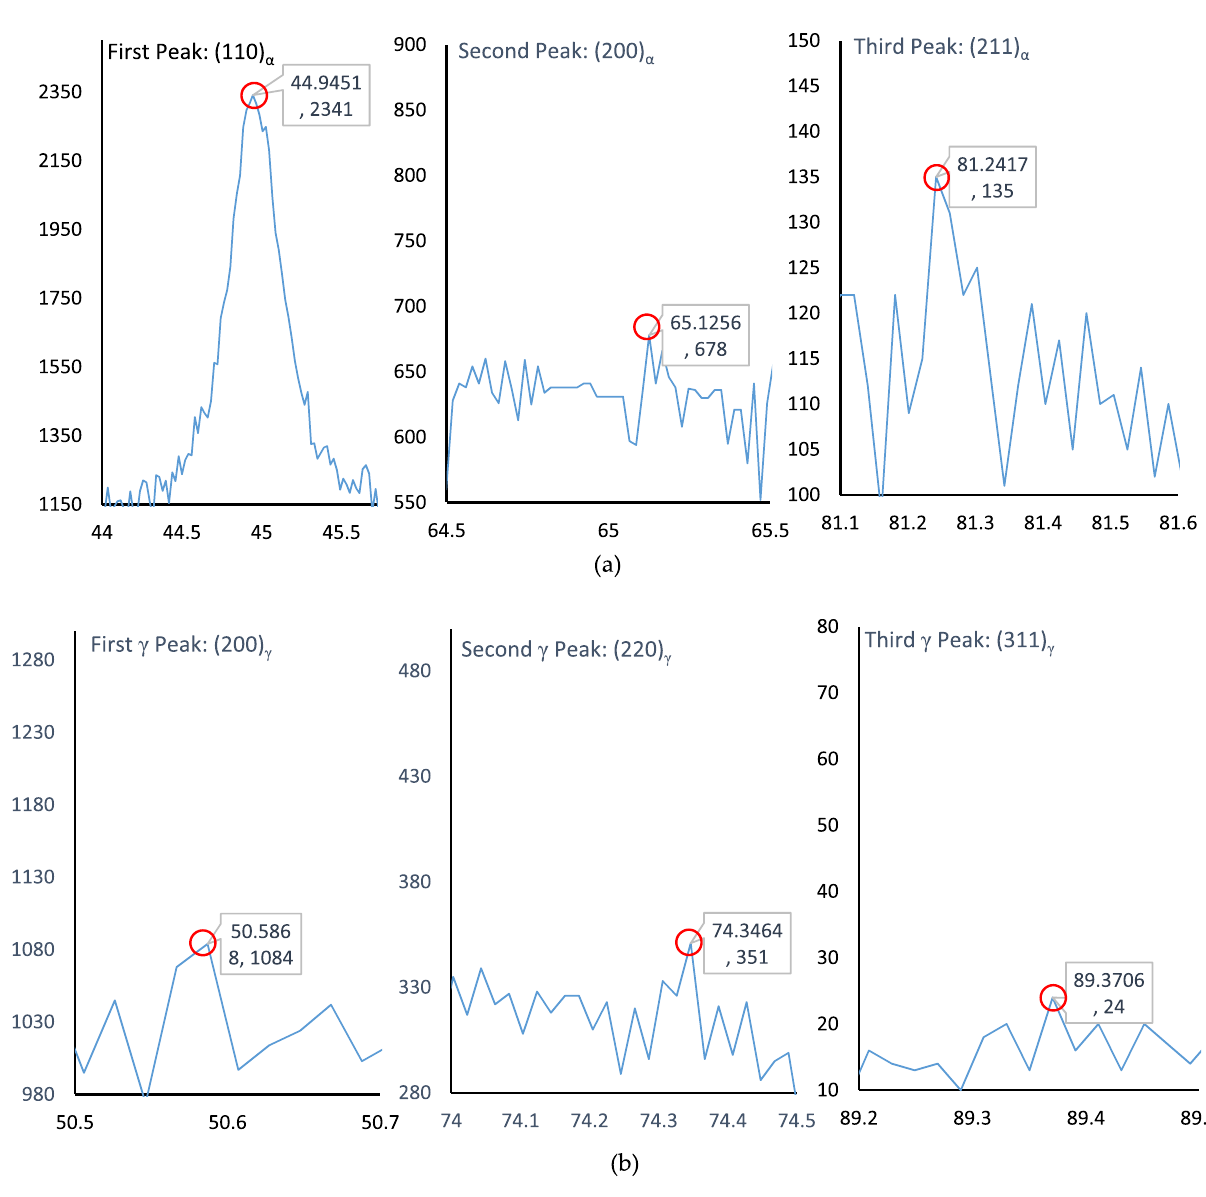
Figure 4. X-ray diffraction peaks of quench and partitioning heat treated microalloyed low carbon steel for ferrite ( a ) and austenite ( b ) used to estimate the amount of retained austenite.